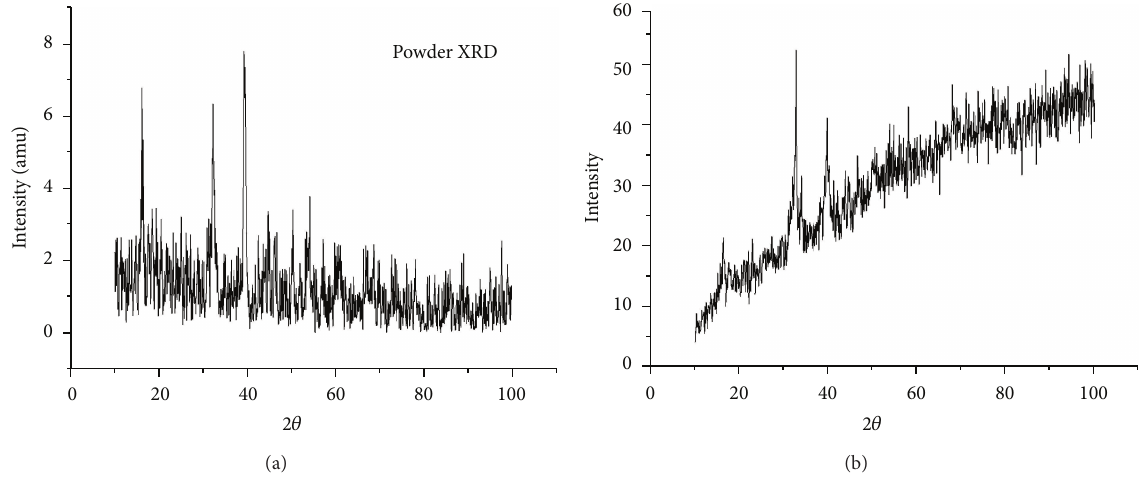
Figure 7: (a) XRD graph for [Co 2 LCl 2 (H 2 O) 6 ] complex. (b) XRD graph for [Co 2 L 󸀠 Cl 2 (H 2 O) 6 ]